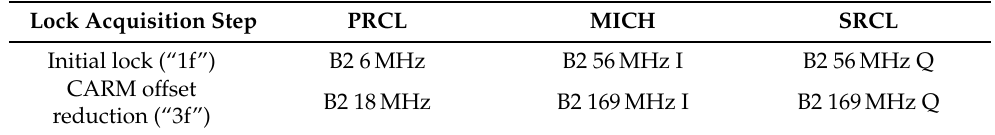
Table 1. Planned error signals for the longitudinal control of the DRMI